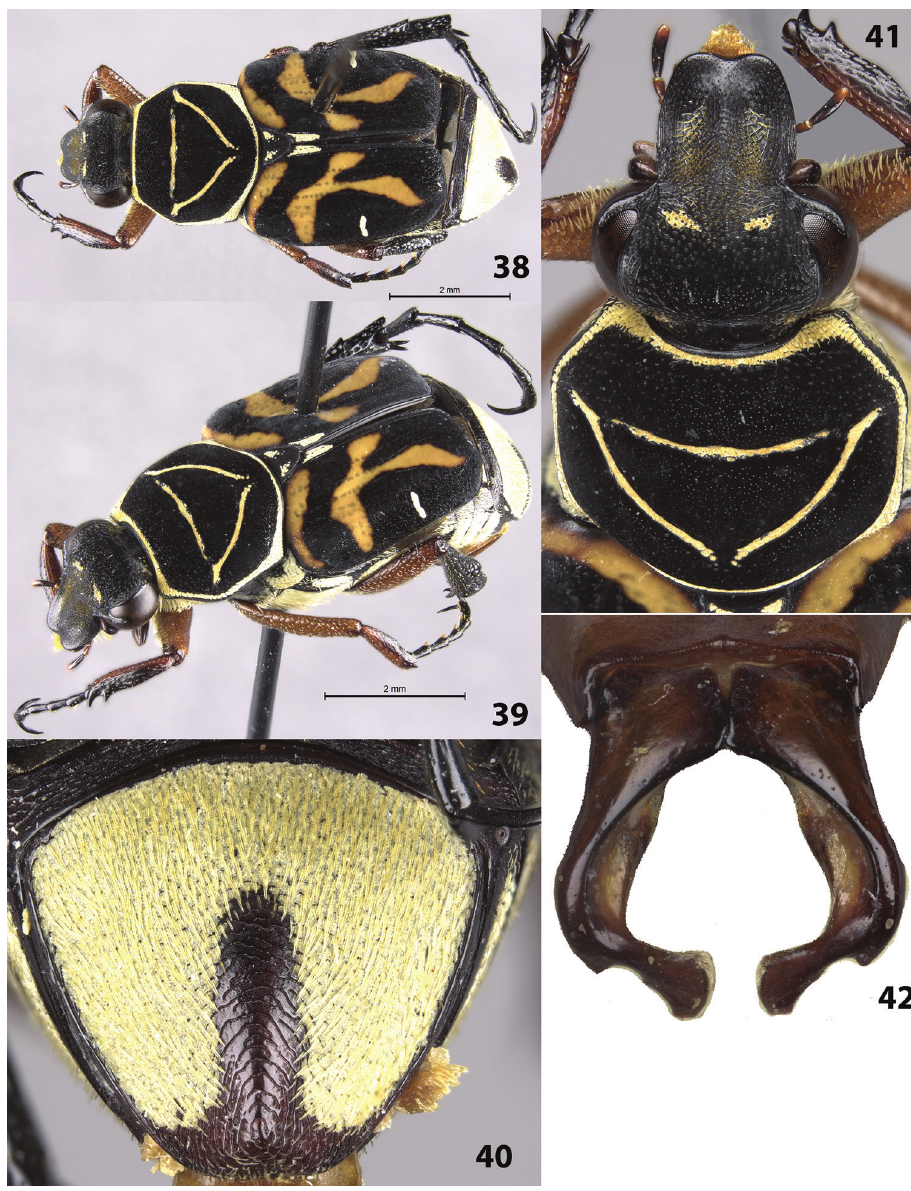
Figures 38–42. Trigonopeltastes warneri sp. n., male holotype. 38 Dorsal view of habitus 39 Oblique view of habitus 40 Pygidium 41 Head and pronotum 42